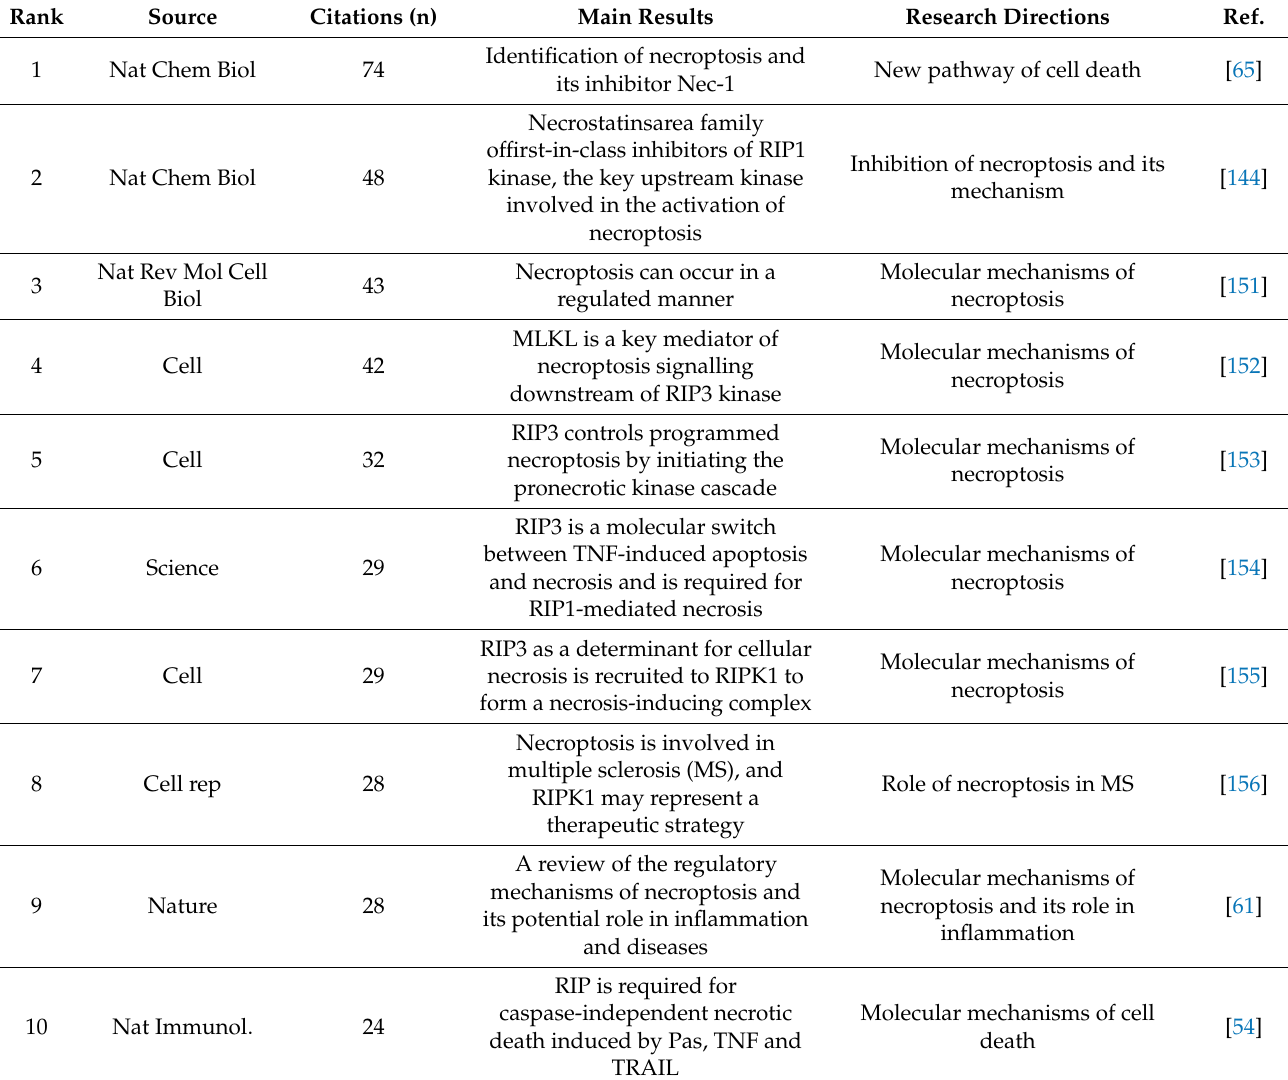
Table 2. Top 10 necroptosis-related articles with the highest co-citations in the field of